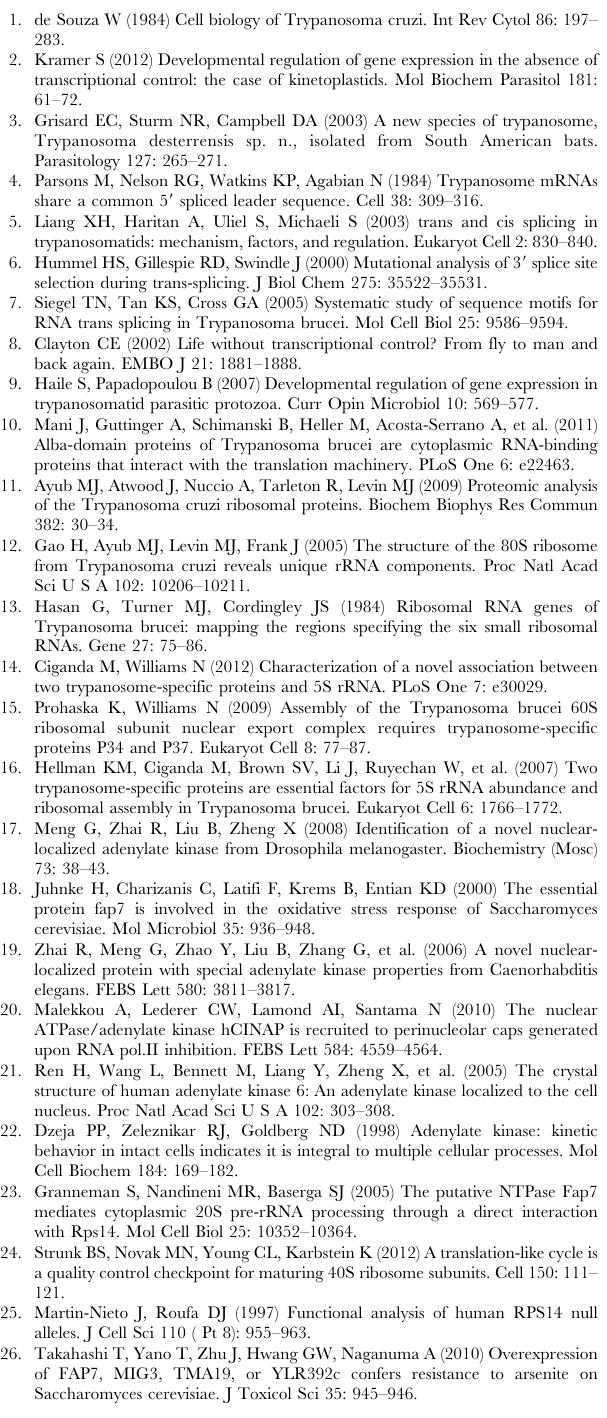
Table S2 Primers. All primers mentioned in the text used for NLS mapping, Real time PCR, RNA isolation and for general purposes are